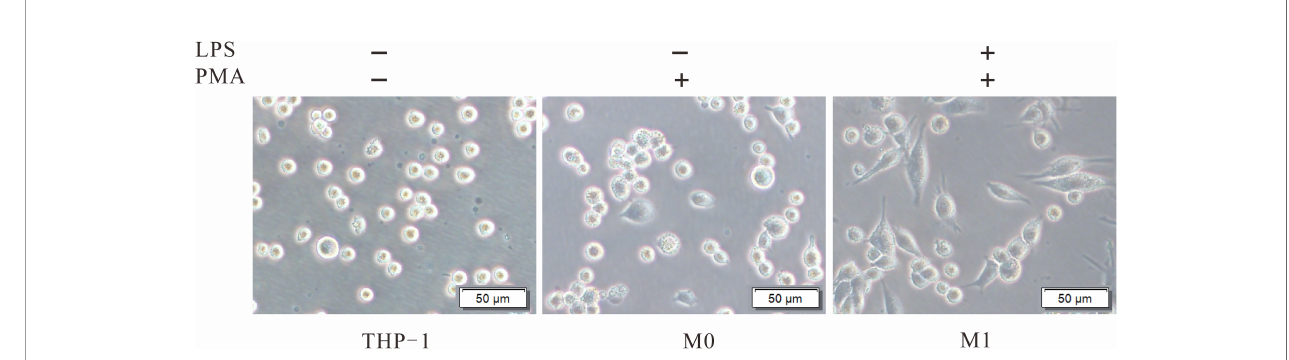
FIGURE 3 | Morphological changes of THP-1 induced by PMA and LPS. THP-1 cells were cultured with PMA (20 ng/ml) for 48 h to transform into M0. After culture without PMA for 24 h, the M0 macrophages were treated with LPS (1 µg/ml) for 24 h to induce M1. PMA, phorbol-12-myristate-13-acetate; LPS, lipopolysaccharide; M0, undifferentiated macrophage; M1,